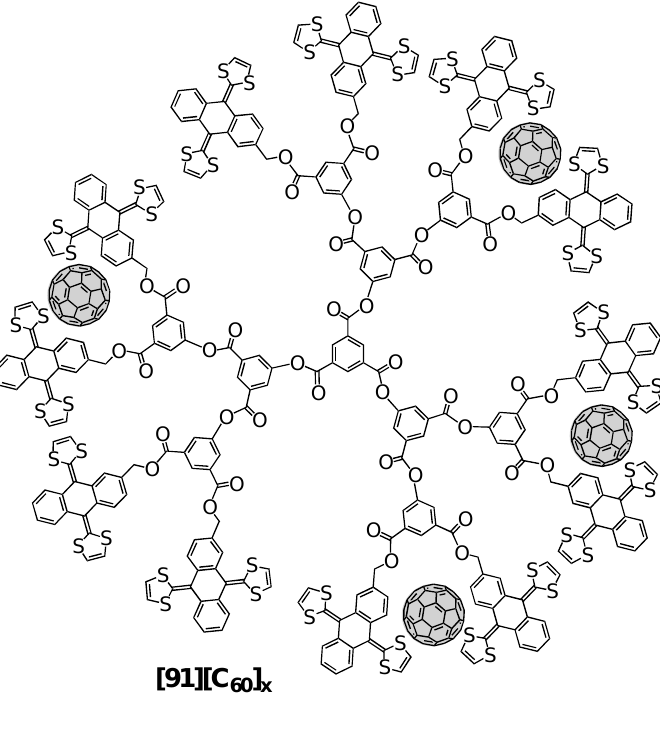
Figure 18. Supramolecular complexation of C third generation dendrimer 91